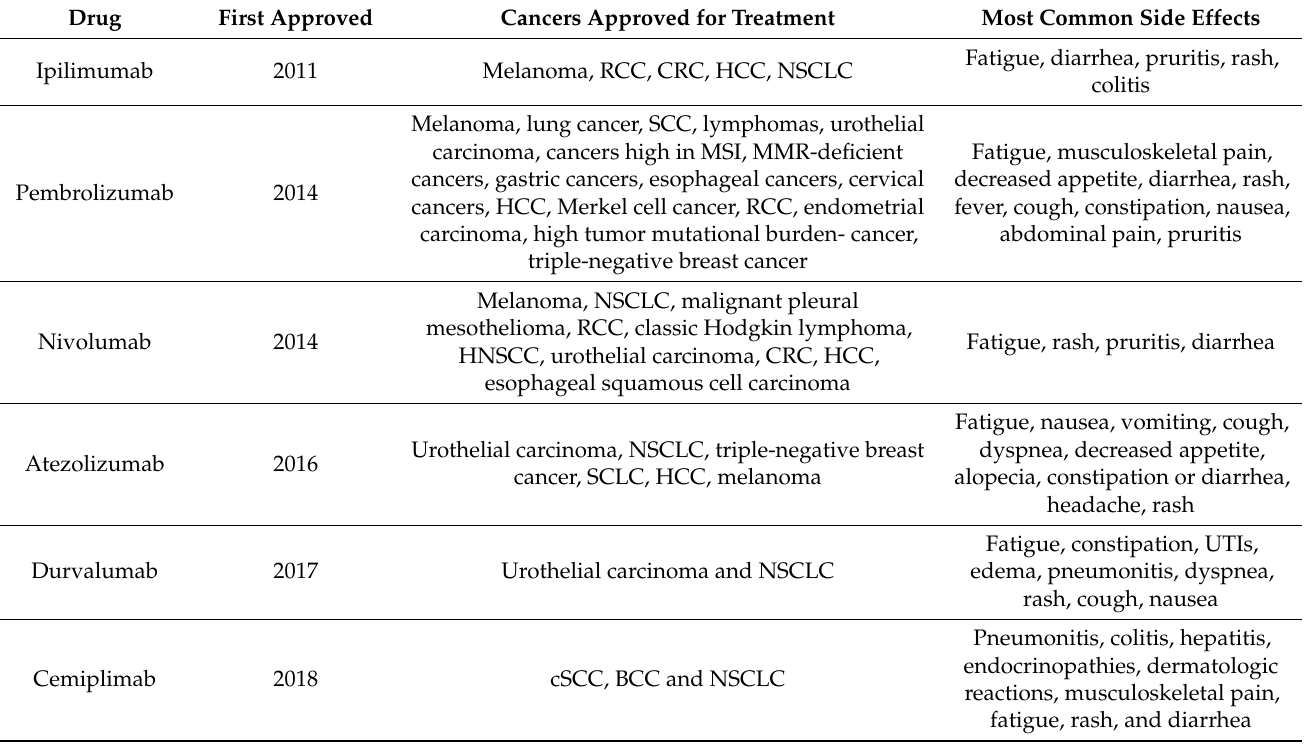
Table 2. Immune Checkpoint Inhibitors, Indications, and Side